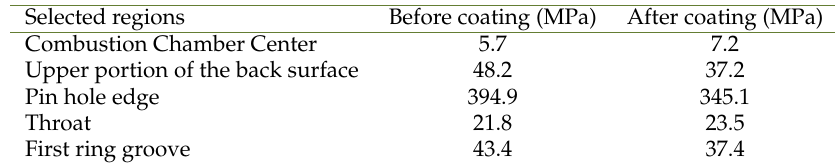
Table 4. Comparison of thermal stresses of the selected